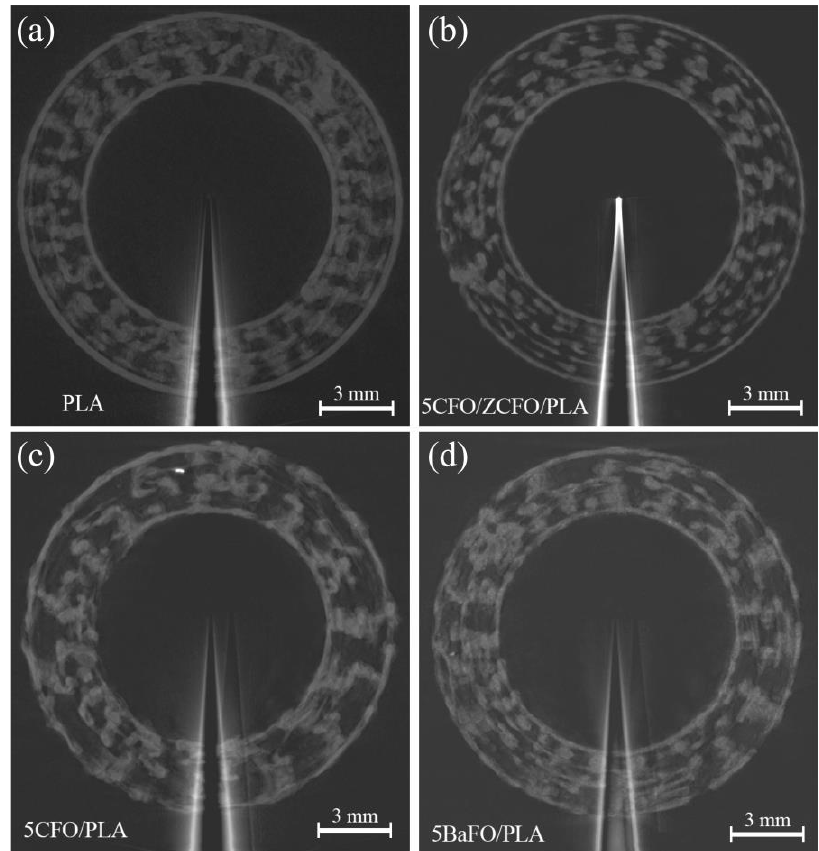
Figure 5. XCT slices of ring-shaped objects printed from pure ( a ) and composite filament ( b – d